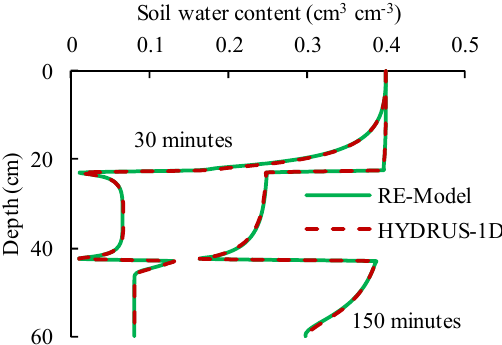
Figure 2. The comparison of the simulated soil water content profiles from the RE-model and HYDRUS-1D for the infiltration case L1S1L1.